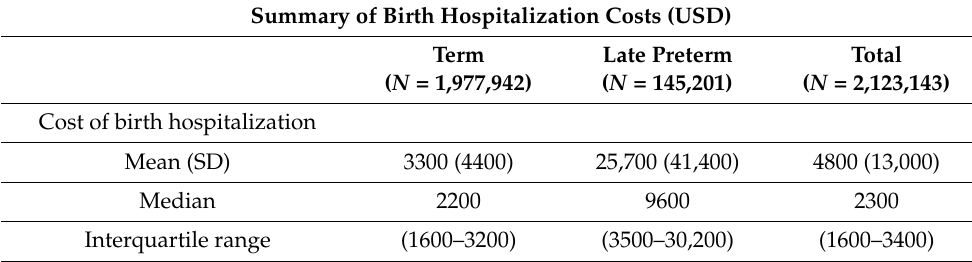
Table 2. Summary of birth hospitalization